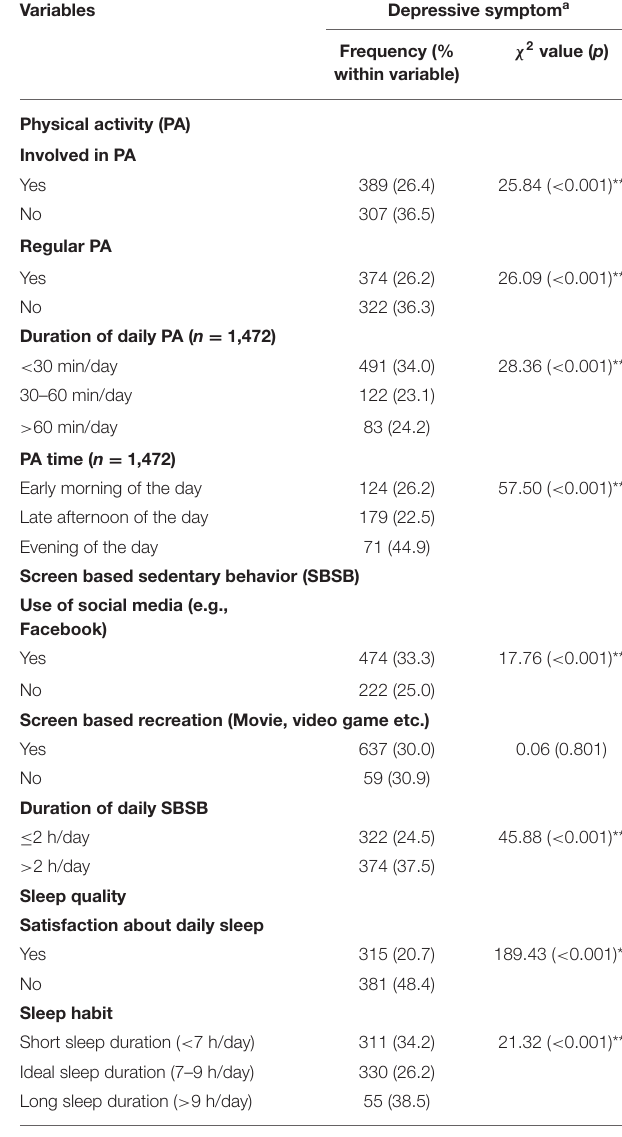
TABLE 1 | Association of socio-demographic variables with students’ depressive symptom.